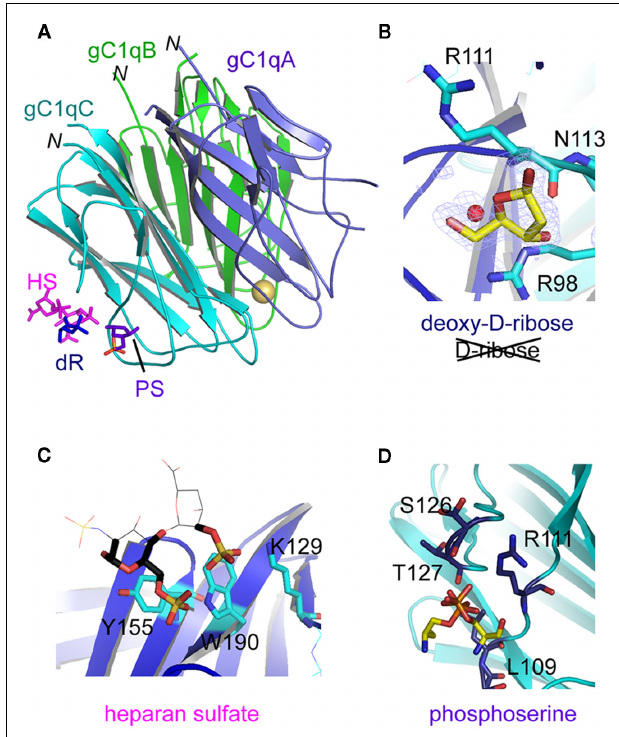
FIGURE 4 | Location of three non-immune self ligand-binding sites in the C1q globular domain. (A) Overall view of the C1q globular domain indicating the relative positioning of the binding sites for heparan sulfate (HS), deoxy-D-ribose (dR), and phosphoserine (PS). (B–D) Detailed views of the binding sites for deoxy-D-ribose, heparan sulfate, and phosphoserine, respectively. Residues of the C subunit involved in the interaction are shown. In (C) , the ligand portion displayed in sticks corresponds to the major interpretable extra electron-density. In ( D ), a double conformation was used to interpret the extra-density corresponding to phosphoserine. (Modified from Garlatti et al., 2010 and Païdassi et al.,